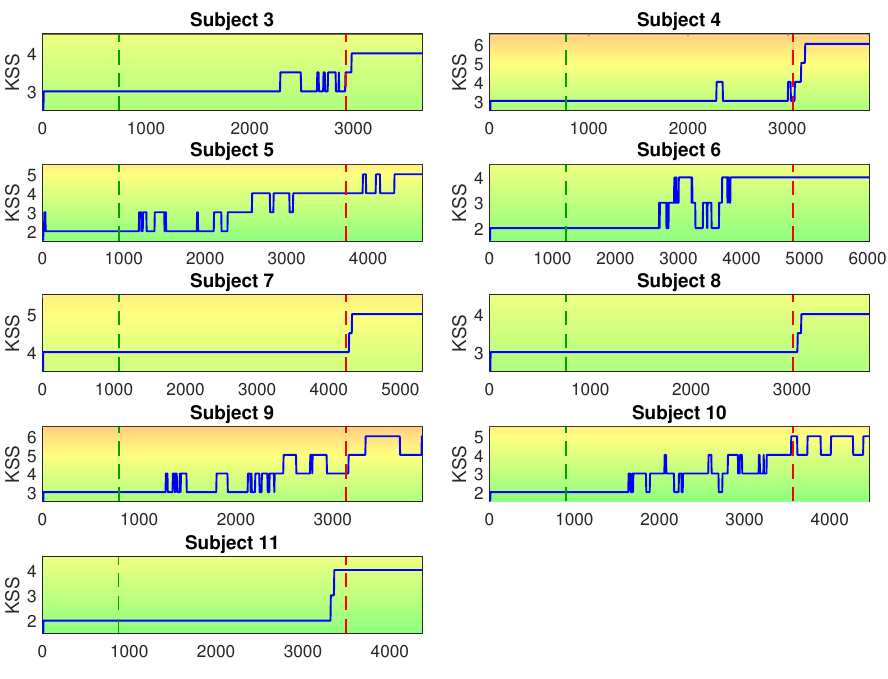
Figure 11. MF assessment for Case 3, for all available subjects. The horizontal axis is presented in seconds. The vertical green dashed line marks the superior limit of the data used for training the non-fatigue condition. The vertical red dashed line marks the inferior limit of the data used for training the fatigue condition. The EEG sensor presented the best classification performance, but transitions between different MF levels can be